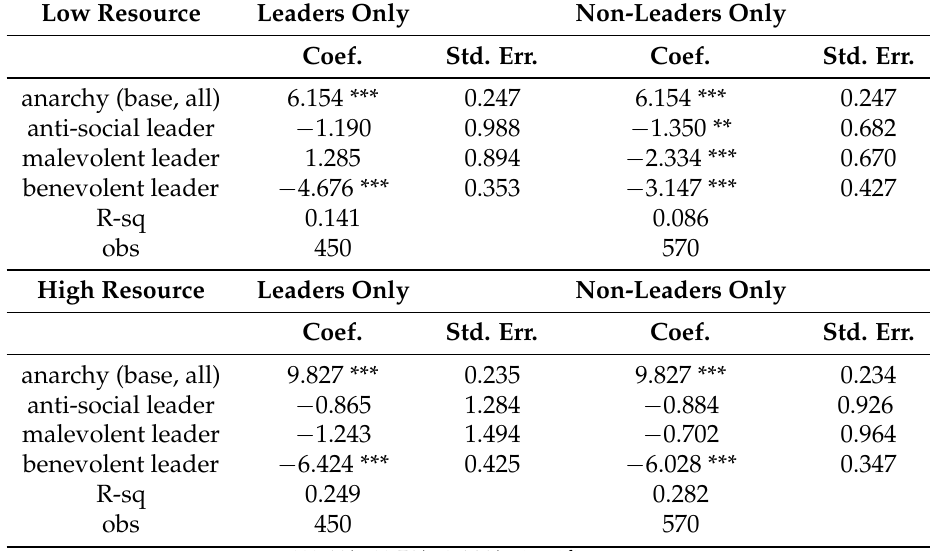
Table 6. Impact of leader behavior on individual conflict investment by type. Random error-Generalized least squares regression with robust standard errors; Dependant variable: individual